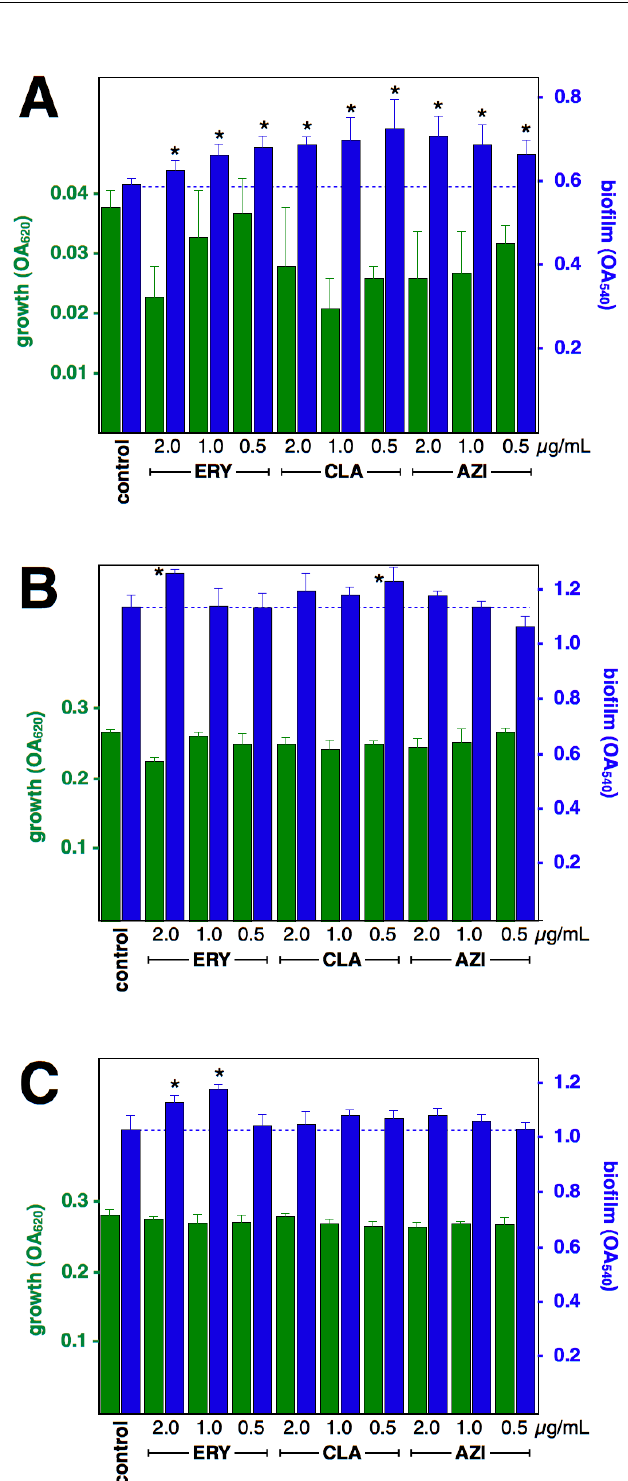
Figure 2. Effect of macrolides upon biofilm formation by S. aureus strain c2 (constitutive MLS B ). Growth (green) and biofilm formation (blue), at 4 h ( A ), 8 h ( B ) and 12 h ( C ), shown as OA at 620 and 540 nm, respectively (means and standard deviations of four independent experiments). * p < 0.05 by Student t -test against control. Growth was significantly ( p < 0.05) reduced by ERY 2 µ g/mL and CLA and AZI at 4-h incubations and by ERY 2 µ g/mL/8 h, yet biofilm formation was significantly larger than control.